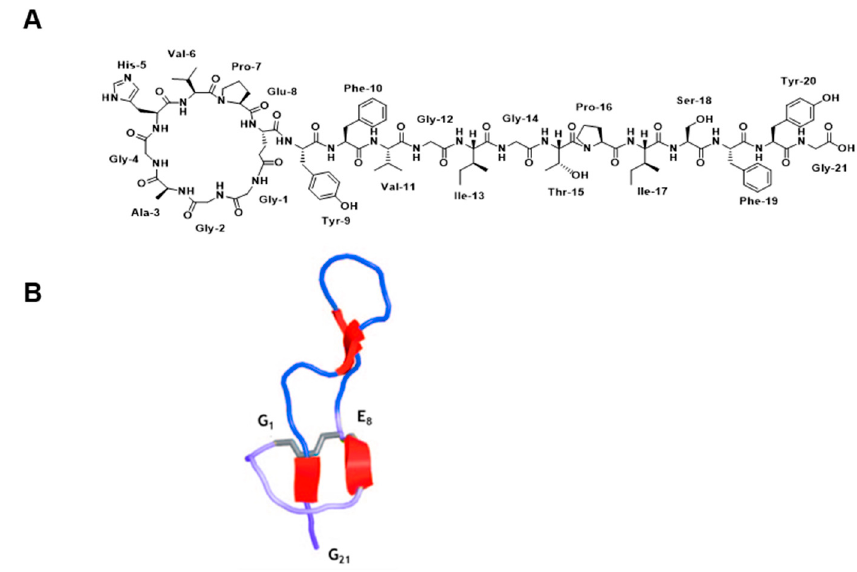
Figure 1. ( A ) Chemical structural and ( B ) ribbon representation of the 3D structure of MccJ25 (Protein Data Bank (PDB) code: 1Q71). The four fragments of antiparallel β -sheets are shown in red. Reprinted